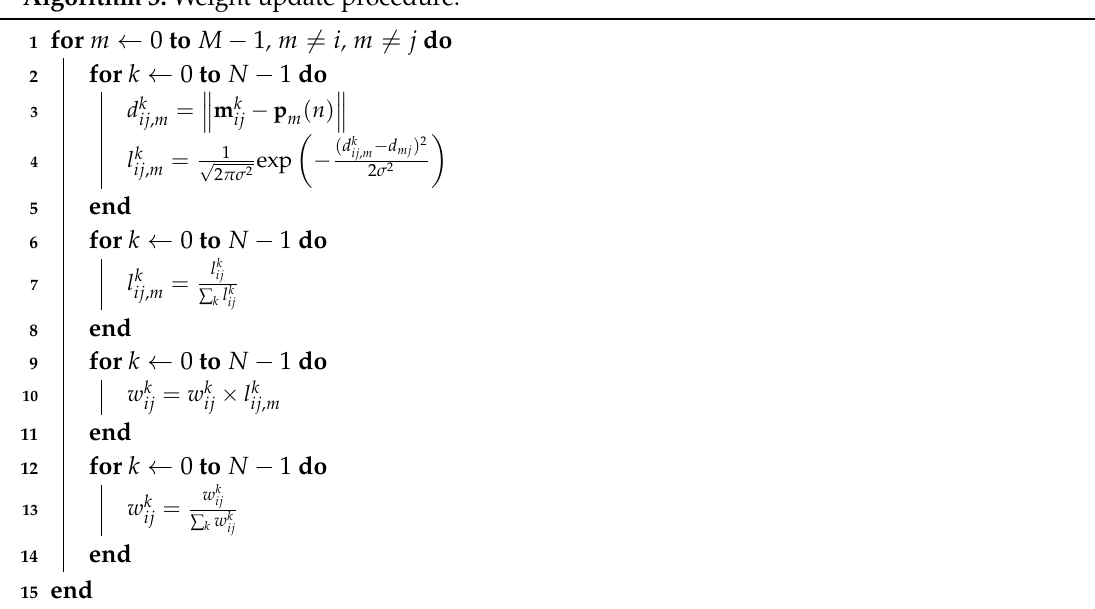
Algorithm 3: Weight update